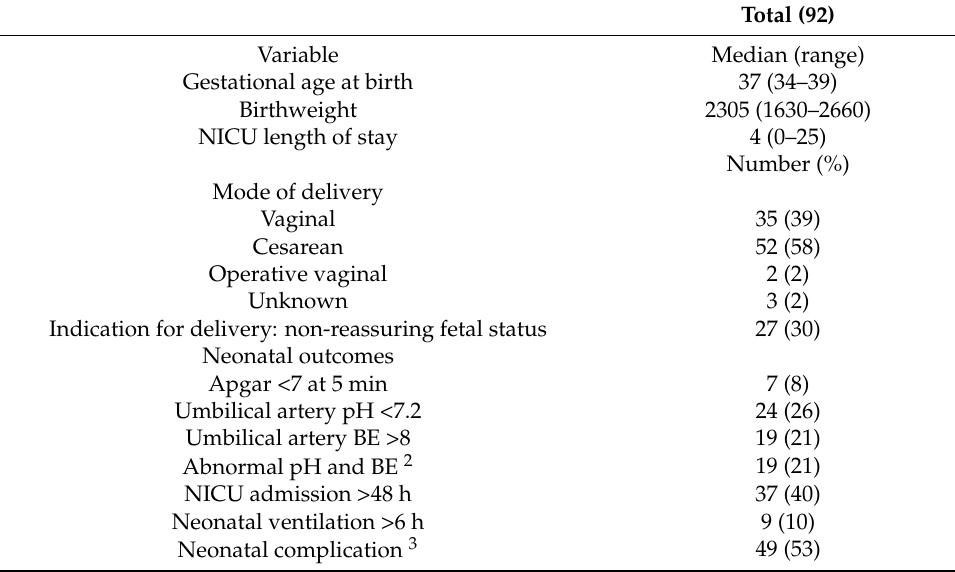
Table 2. Delivery and neonatal outcomes 1 .